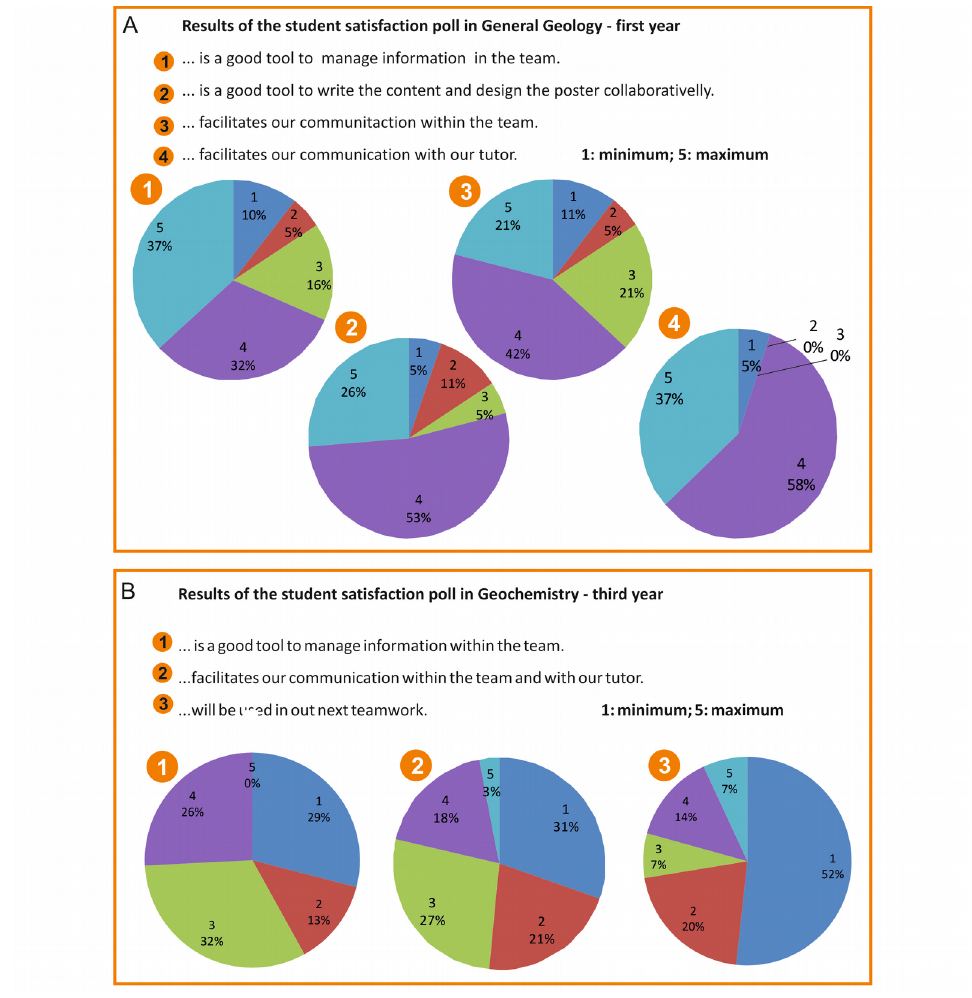
Figure 3. Results of the student satisfaction poll in the subjects where